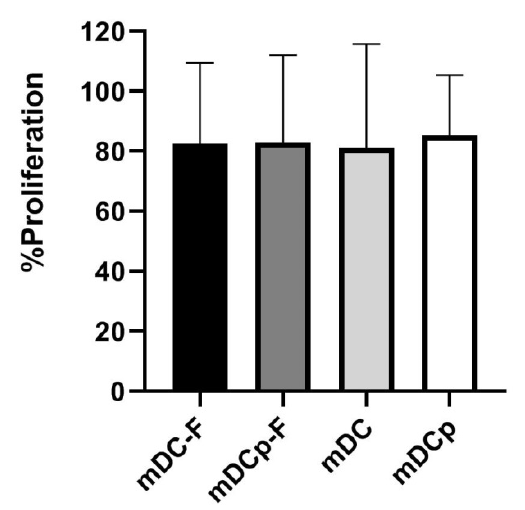
Figure 6. Mixed lymphocytes reaction. DC functionality was evaluated via one-way allogeneic mixed lymphocyte reaction (MLR). Colorimetric variation of MTT reagent was used to detect cell proliferation. All DC analyzed were potent stimulatory cells; the comparison between Fast and standard method showed that there are no differences in DC’s ability to induce allogeneic MLR. Bar graphs show the mean proliferation ± SD.